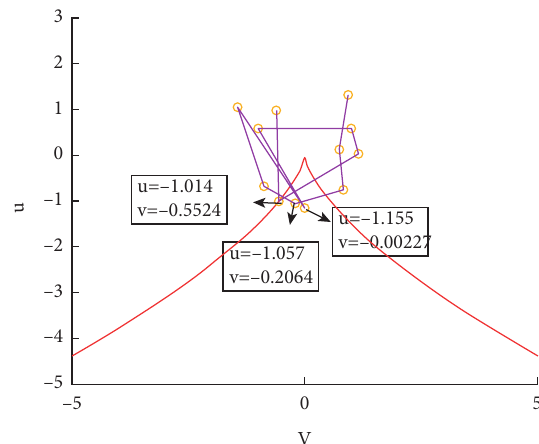
Figure 7: Plane projection of sudden changes in Shanghai crude oil futures prices in